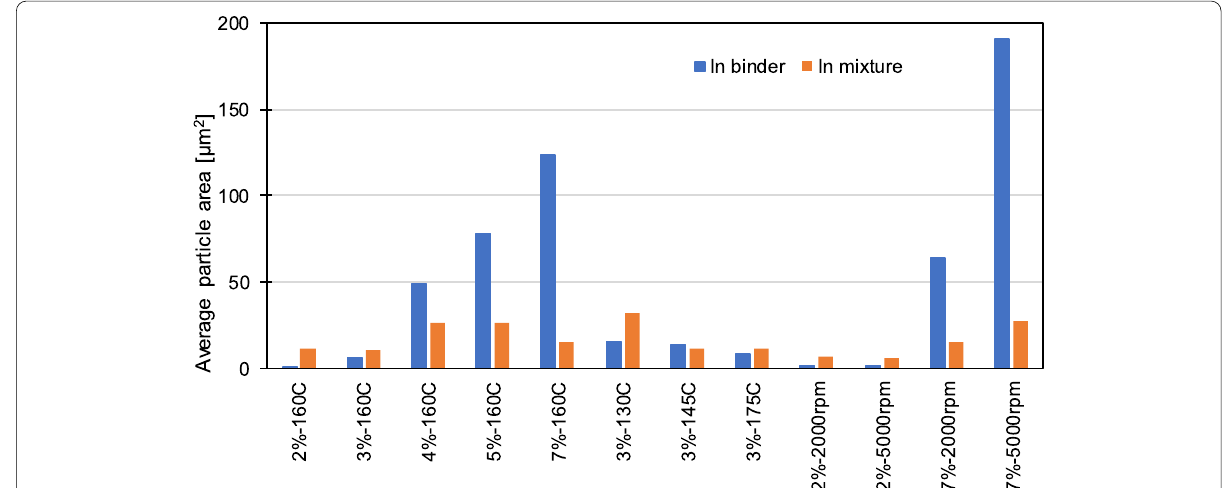
Fig. 13 Comparison of SBS average particle area in asphalt binder and their mixtures